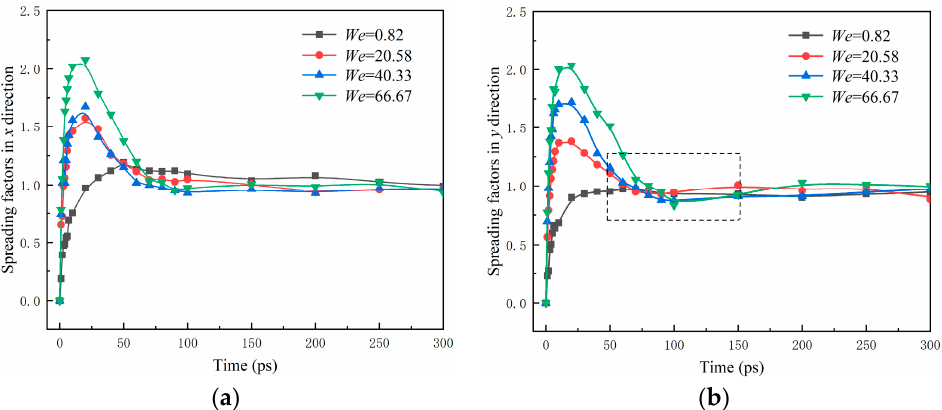
Figure 11. Time evolution of spreading factors in x and y directions: ( a ) β x ; ( b ) β y .